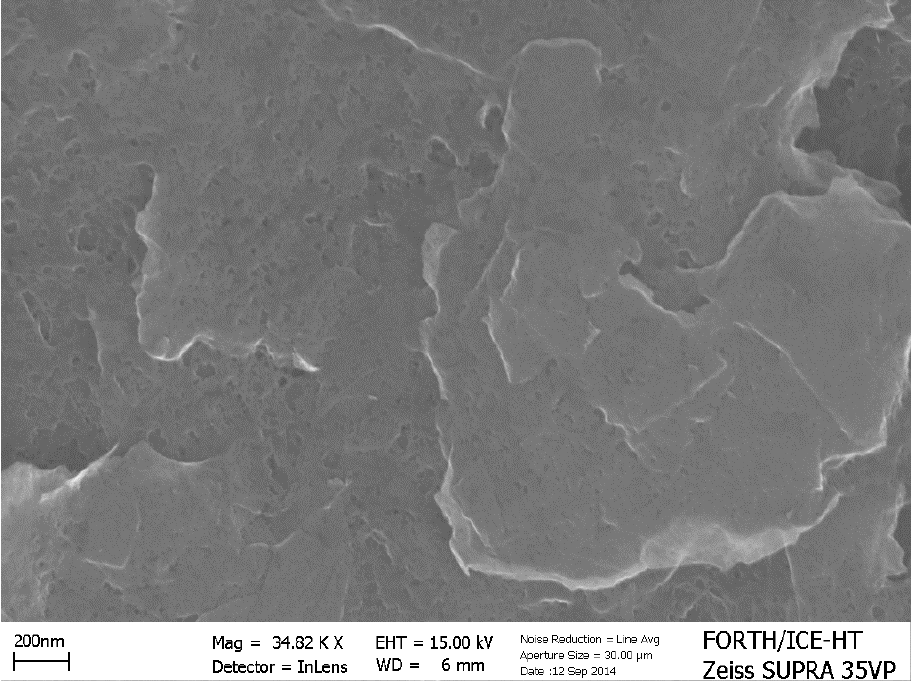
Figure 7. FESEM image of the Elcocarb film. The scale bar is 200